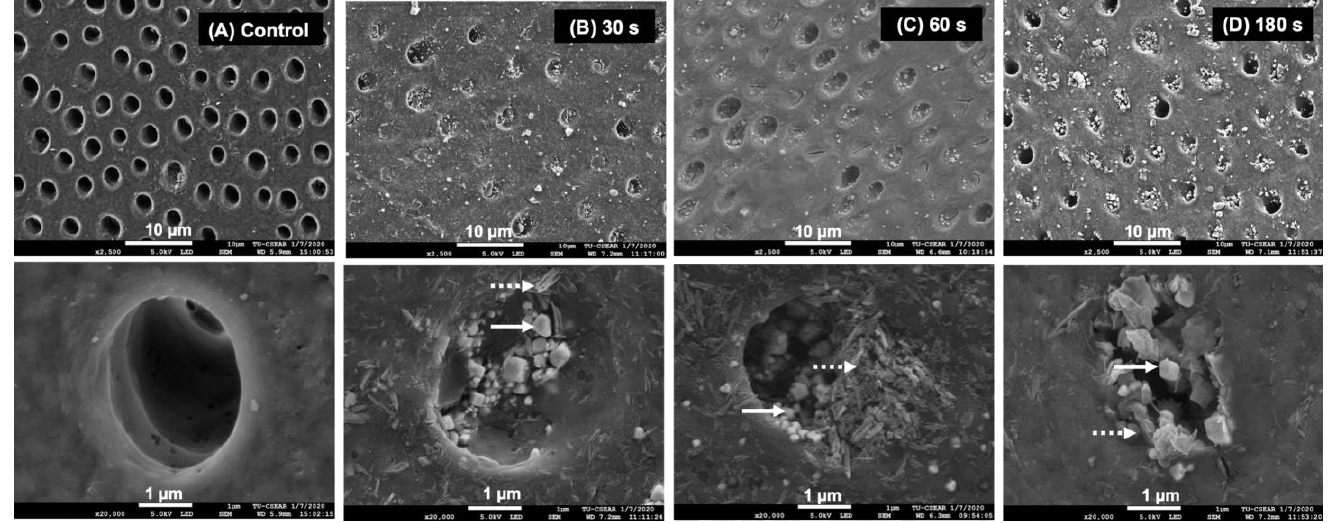
Figure 4. SEM images at low and high magnification of a representative specimen from each group after 2 weeks. ( A ) The surface of the specimen from the control group showed no mineral precipitation. Precipitation occluding dentinal tubules was detected in the specimens from the ( B ) 30, ( C ) 60, and ( D ) 180 s groups. Irregular shapes (solid arrows) and needle-like precipitates (dash arrows) were observed.